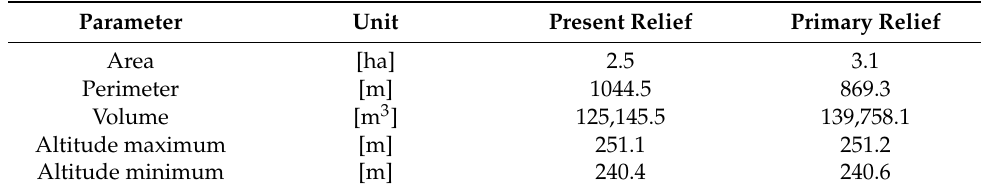
Table 4. The parabolic dune